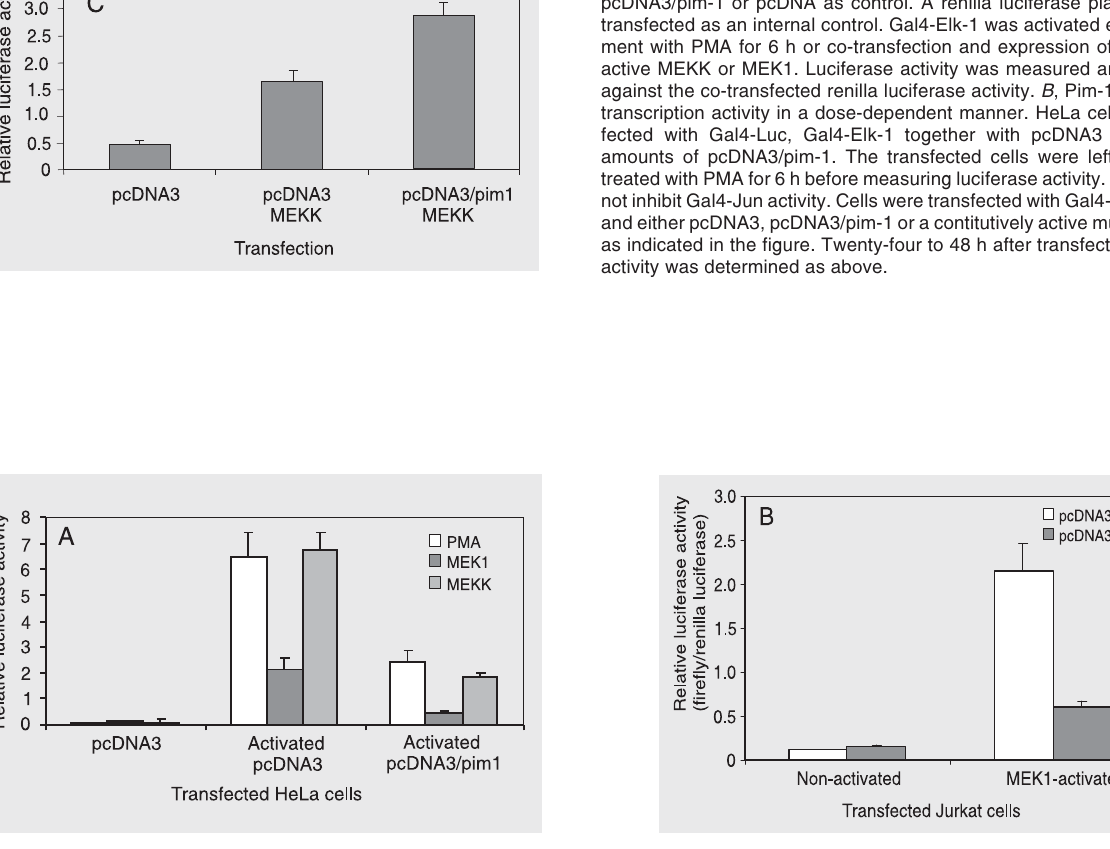
Figure 2. Pim-1 inhibits activation of c-fos reporter. A , In HeLa cells: a luciferase reporter controlled by the c-fos promoter was co-transfected with either pcDNA3 or pcDNA3/pim-1. The reporter was left untreated or activated by either treatment with phorbol myristate acetate (PMA) or co-transfection with constitutively active mutant MEK1 or MEKK as indicated in the figure. B , In Jurkat cells: c-fos reporter was co-transfected by electroporation with either pcDNA3, pcDNA3/pim-1 or constitutively active MEK1 as indicated. Renilla luciferase plasmid was co-transfected as an internal control and luciferase activity was measured as described in Figure 1.